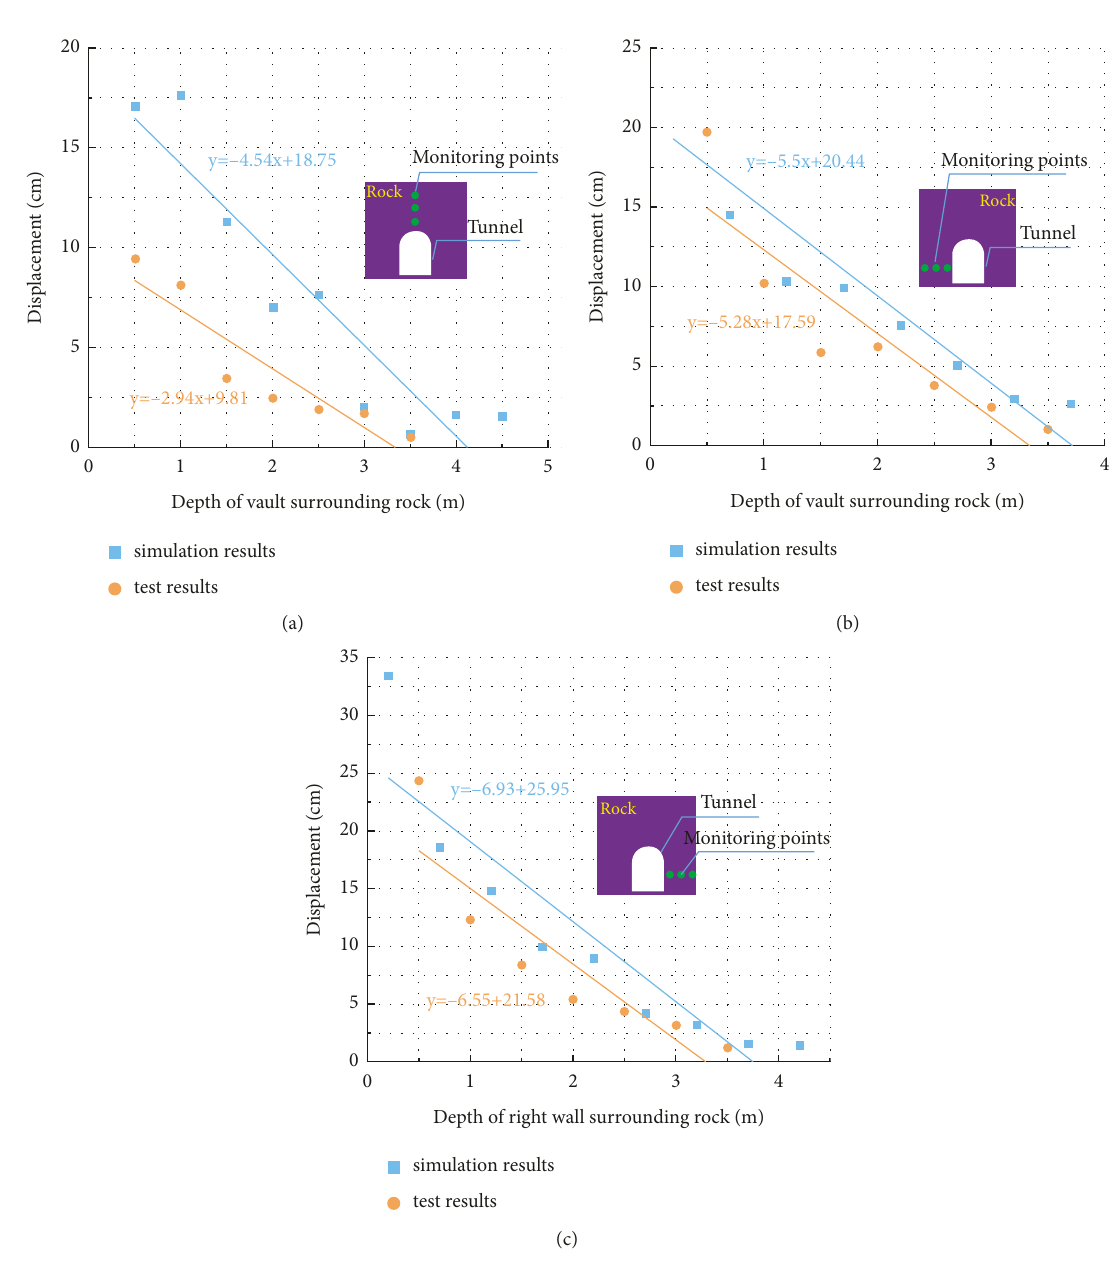
Figure 19: Final displacement test results of the surrounding rock at YK45 +560 section (enlarged): (a) surrounding rock above the tunnel face; (b) surrounding rock of the left side wall; (c) surrounding rock of the right side